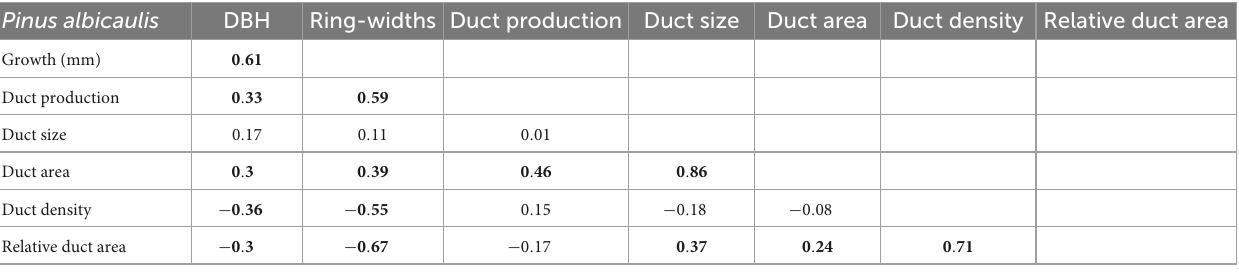
TABLE 1 Spearman correlation coefficients for raw, non-detrended whitebark pine tree size (diameter at breast height; DBH), tree growth (ring-width: mm), resin duct production (no. ducts year − 1 ), duct size (mm 2 ), duct area (mm 2 year − 1 ), and resin duct metrics that have been standardized to